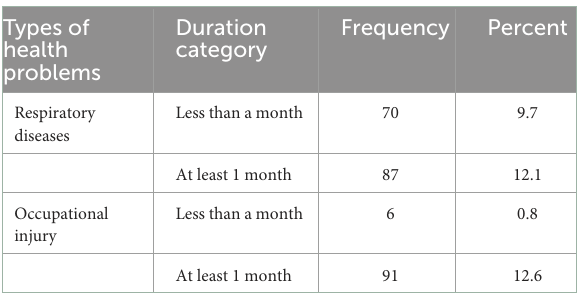
TABLE 2 Types of work-related health problems among workers in coffee industries, Bench-Sheko and Kafa Zones, May/2021.